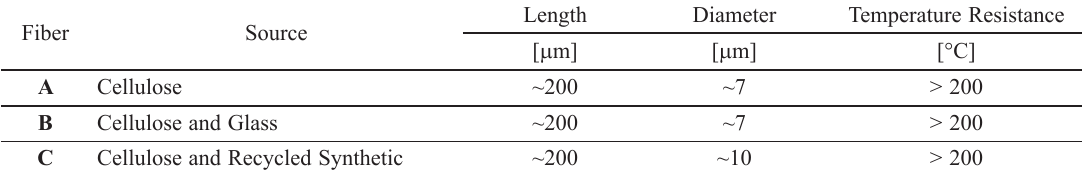
Table 2. Main characteristics of fibers